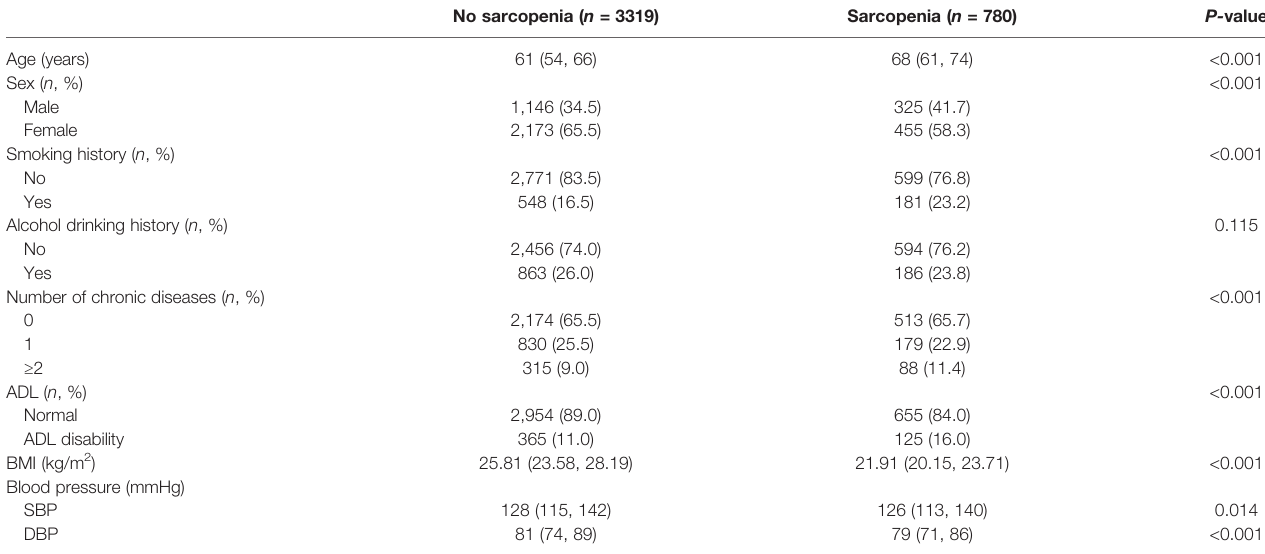
TABLE 1 | Baseline characteristics of the elderly participants strati fi ed by sarcopenia.